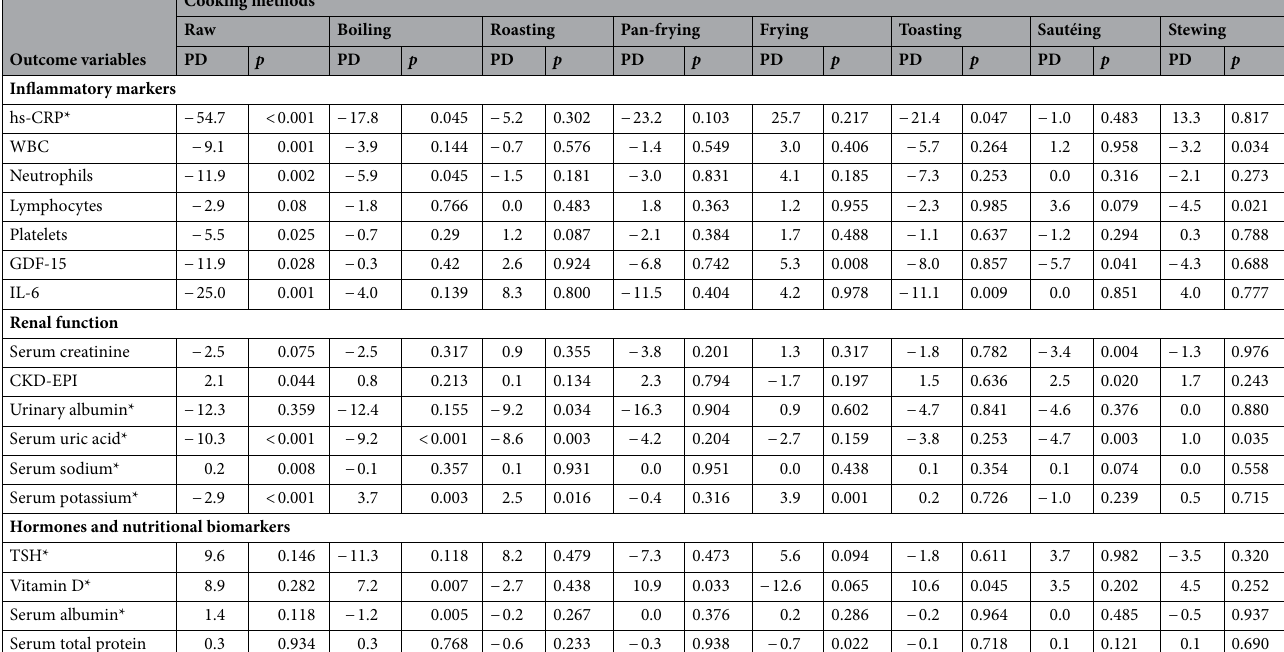
Table 2. Percentage differences (PD) of inflammatory factors, renal function, and other hormones and nutritional biomarkers among cooking methods. PD: percentage difference; measured as a difference between quintile 5 and quintile 1 divided by quintile 1. Hs-CRP: high sensitivity-C reactive protein; WBC: white blood cells; GDF-15: Growth differentiation factor 15; IL-6: Interleukin 6; CKD-EPI: Chronic